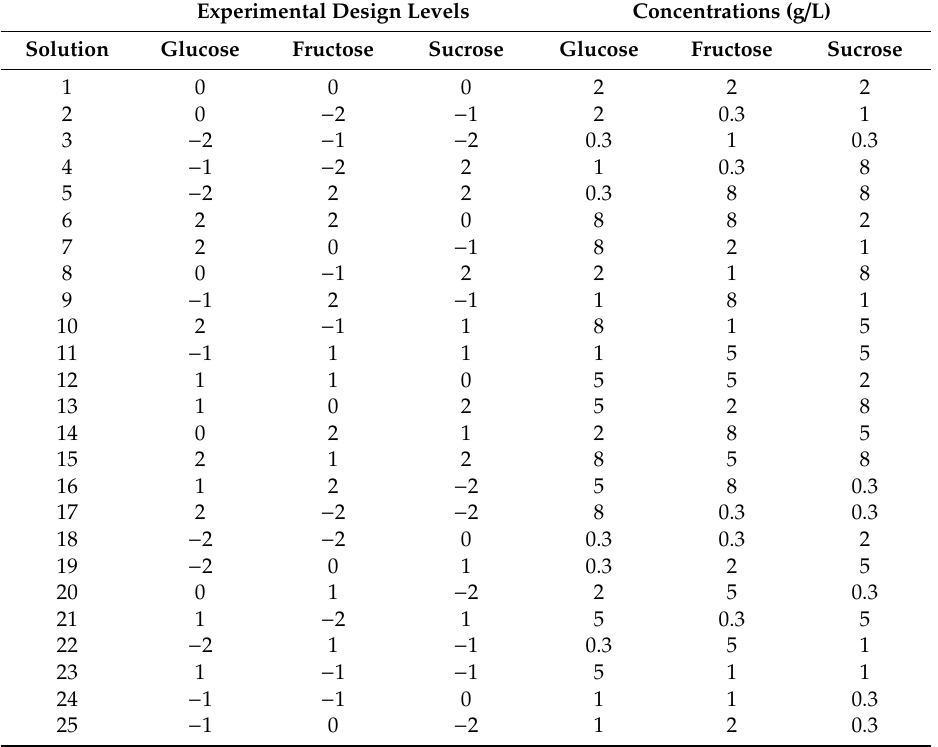
Table 1. Experimental design levels and concentrations of sugars in the standard solutions. Experimental Design